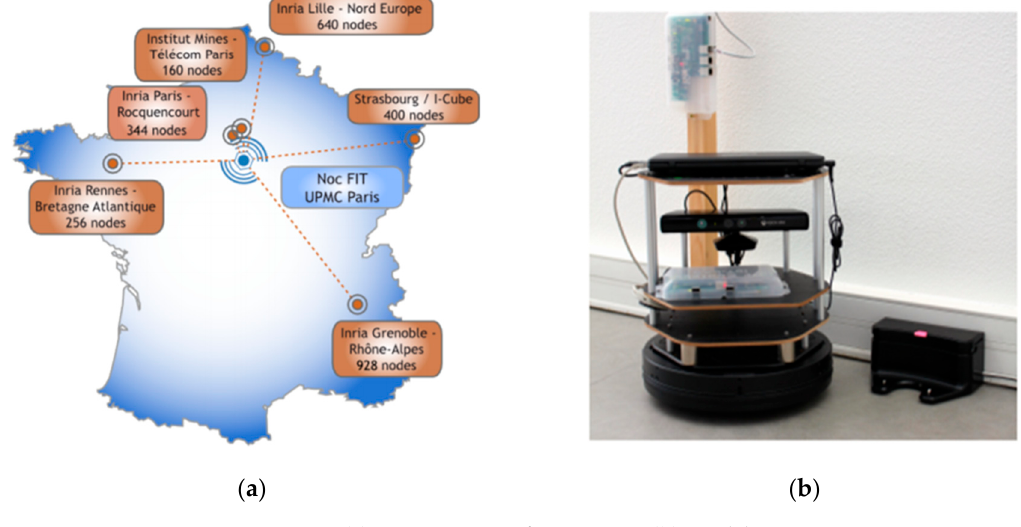
Figure 4. ( a ) FIT IoT LAB infrastructure, ( b ) Turtlebot.